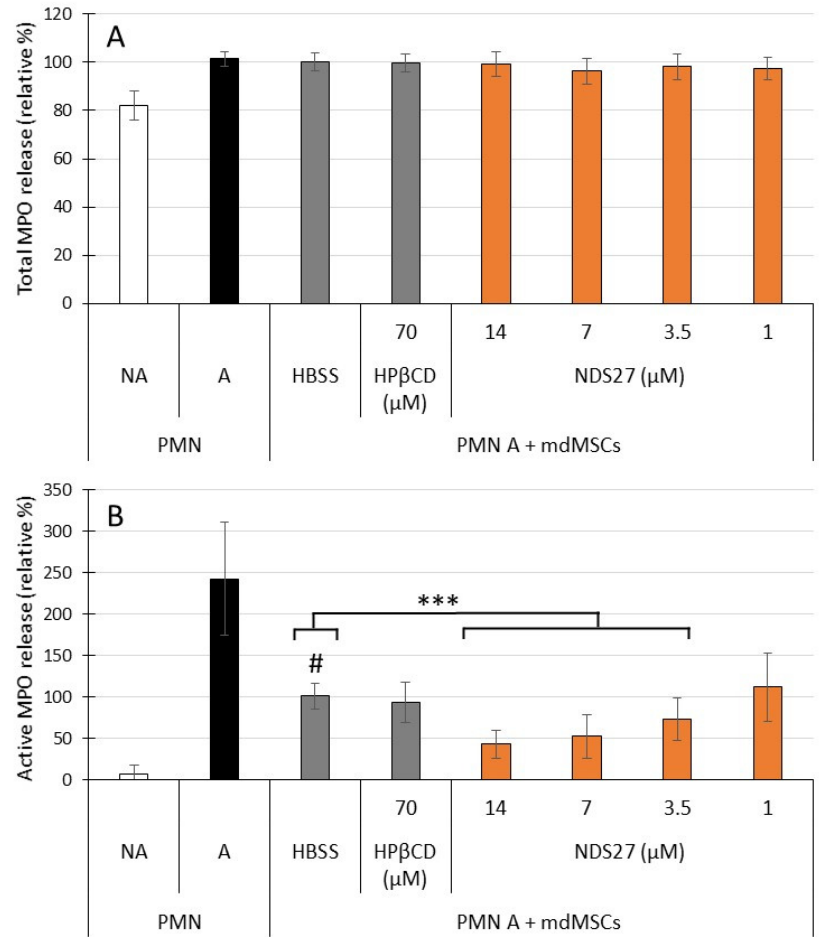
Figure 3. Effect of non-activated (PMN NA) and CB + fMLP activated neutrophils (PMN A) alone or mixed with non-loaded (HBSS) and mdMSCs loaded with HP β CD (70 µ M) and NDS27 (1, 3.5, 7, 14 µ M) on total ( A ); and active ( B ) MPO released by PMNs. The numbers of neutrophil and mdMSCs per 2 mL medium were 1 × 10 6 and 0.5 × 10 6 respectively. Means ± SD are shown in relative percentages versus non-loaded cells (HBSS) in the presence of stimulated neutrophils defined as 100% response. Statistical analysis was considered for 5 independent experiments (2 technical replicates) with mdMSCs from 3 horses. *** p < 0.001 vs. HBSS, # p < 0.001 vs. PMN